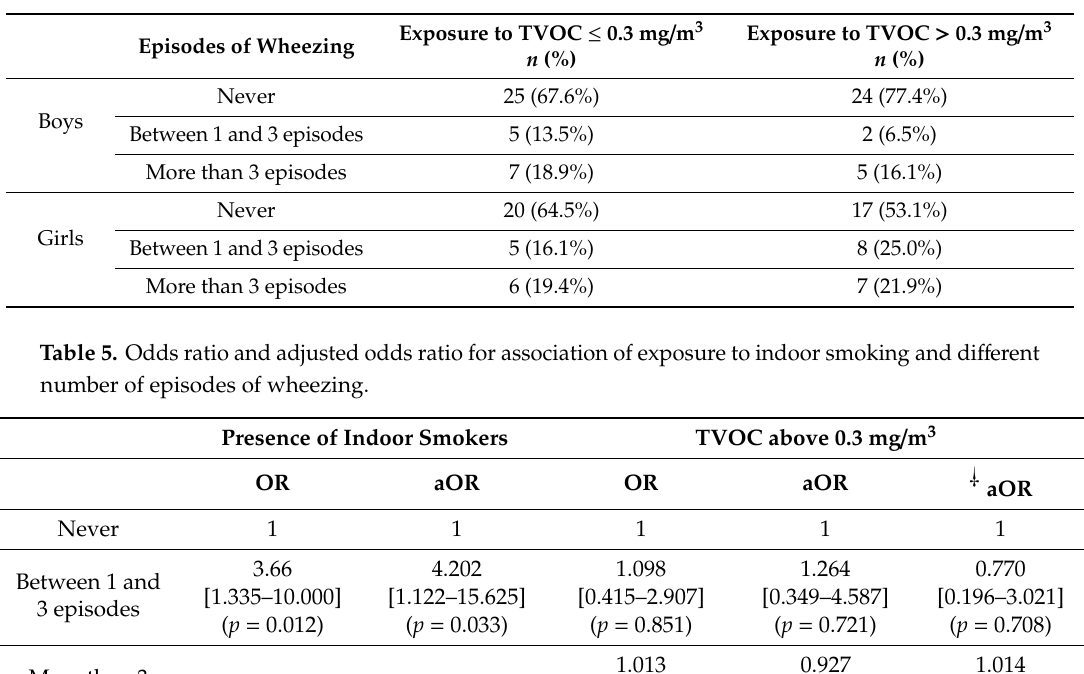
Table 4. Episodes of wheezing by sex and exposure to TVOC ( n = 131). Episodes of Wheezing